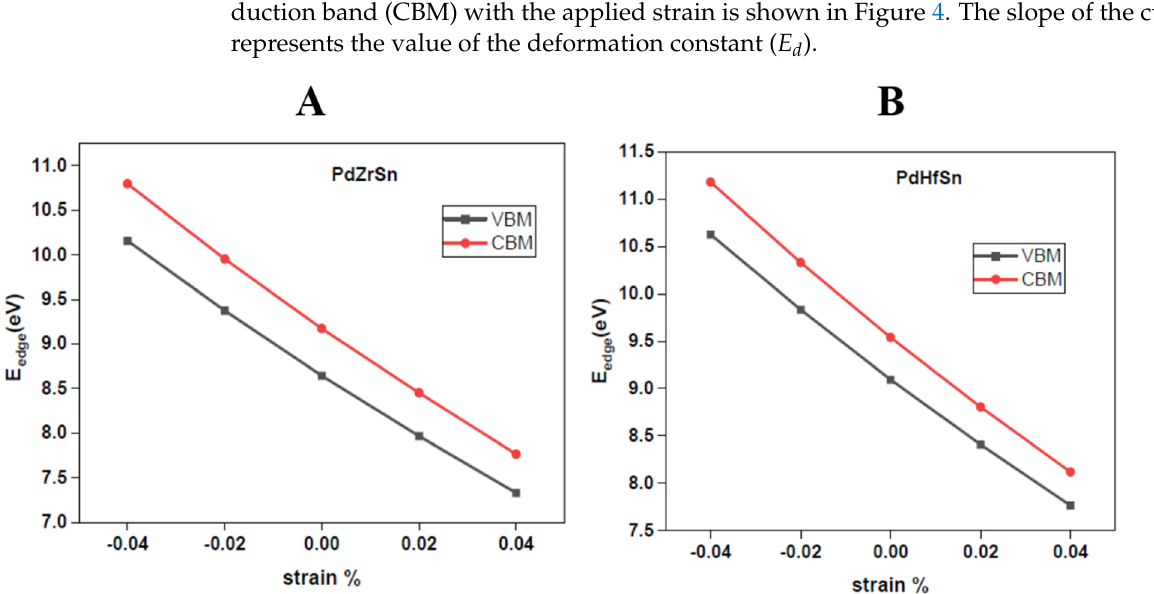
Figure 4. Variation of band edge energy with strain for PdZrSn ( A ) and PdHfSn ( B ).